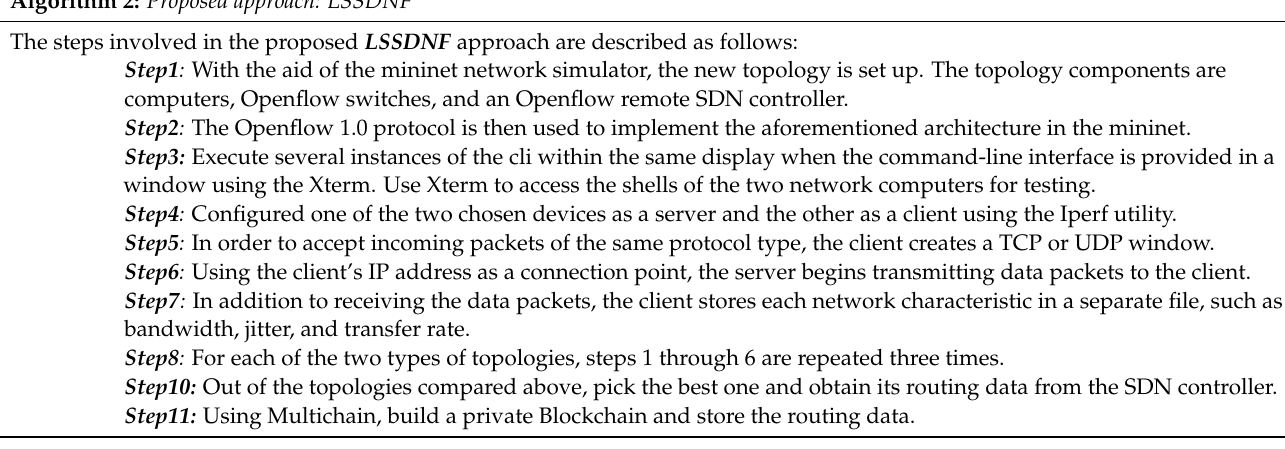
Algorithm 2: Proposed approach: